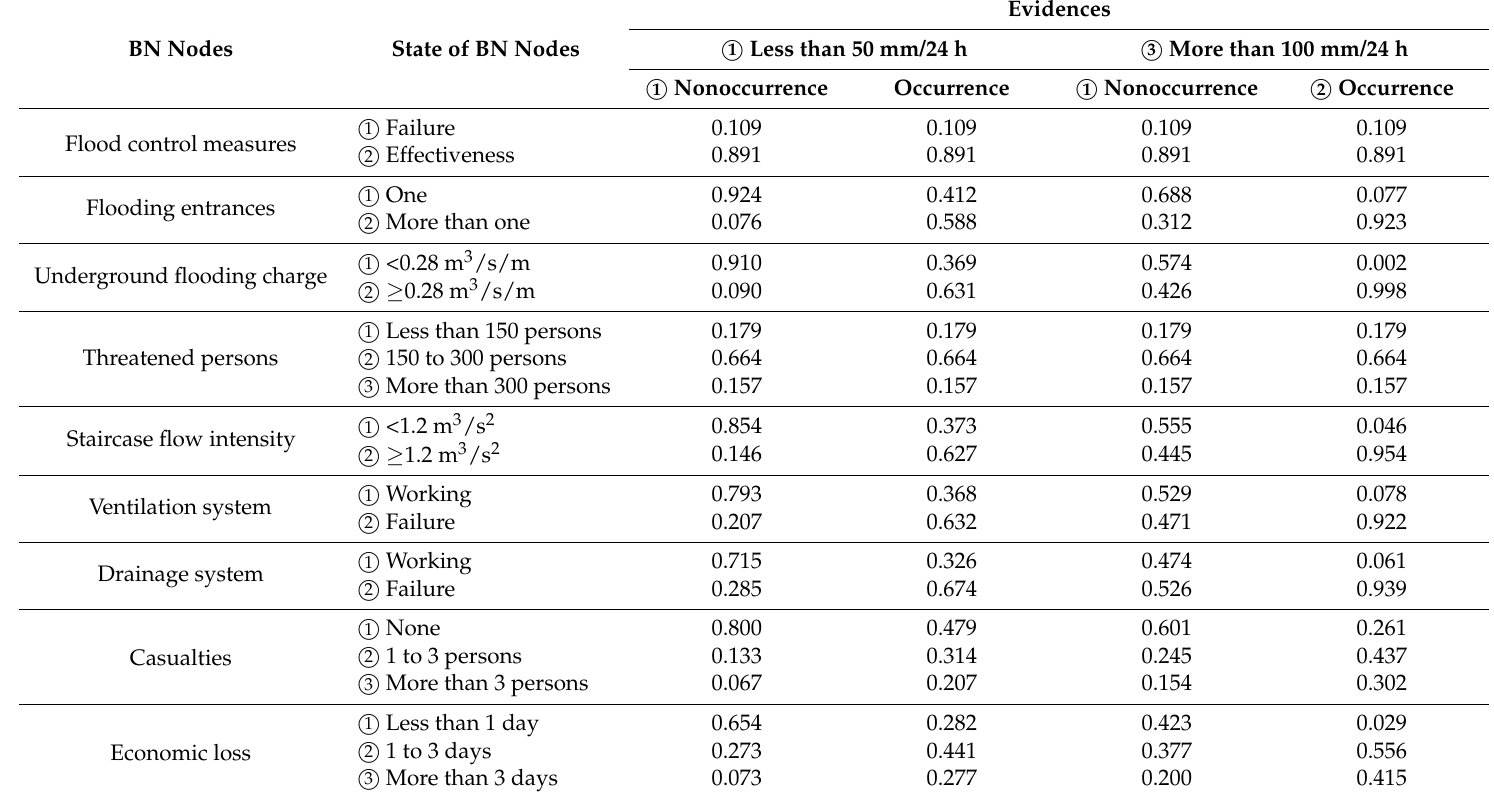
Table 5. Inference probabilities of dike/dam-break flooding in urban underground space and other comparative cases.